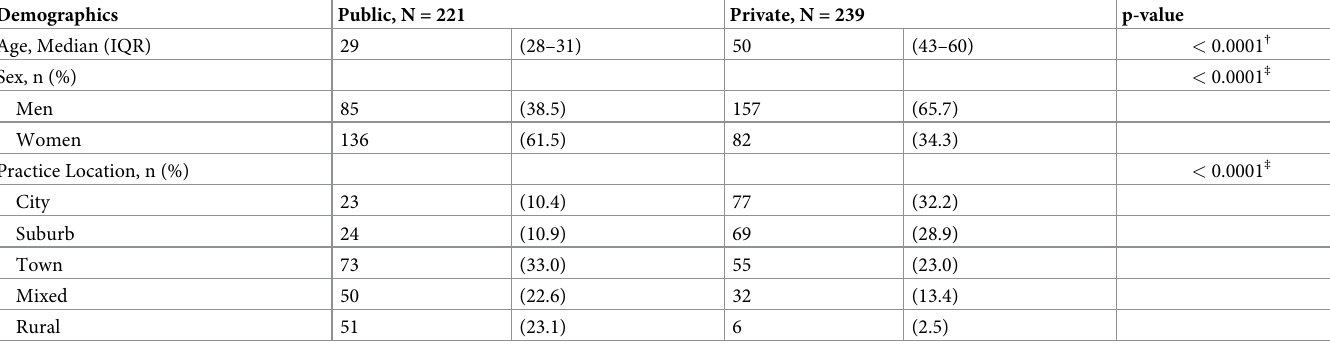
Table 2. Demographics details of the practitioners participated in QUALICOPC by sector.